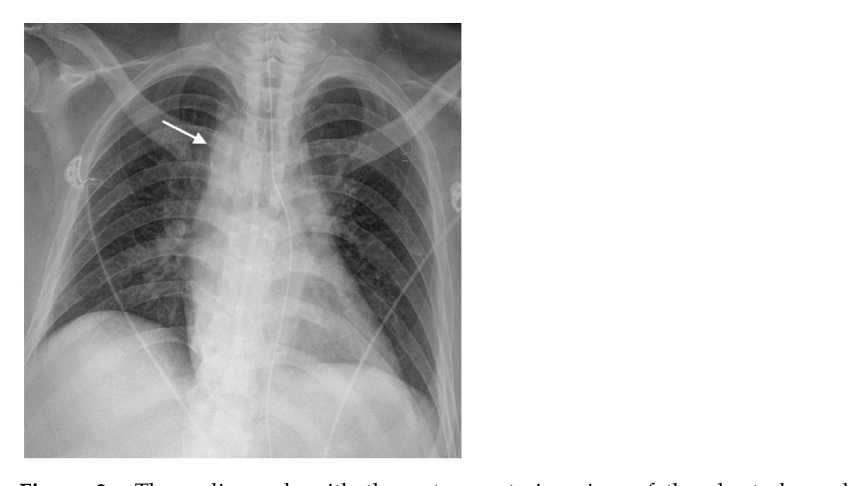
Figure 2. The radiograph with the anteroposterior view of the chest showed a right aortic arch